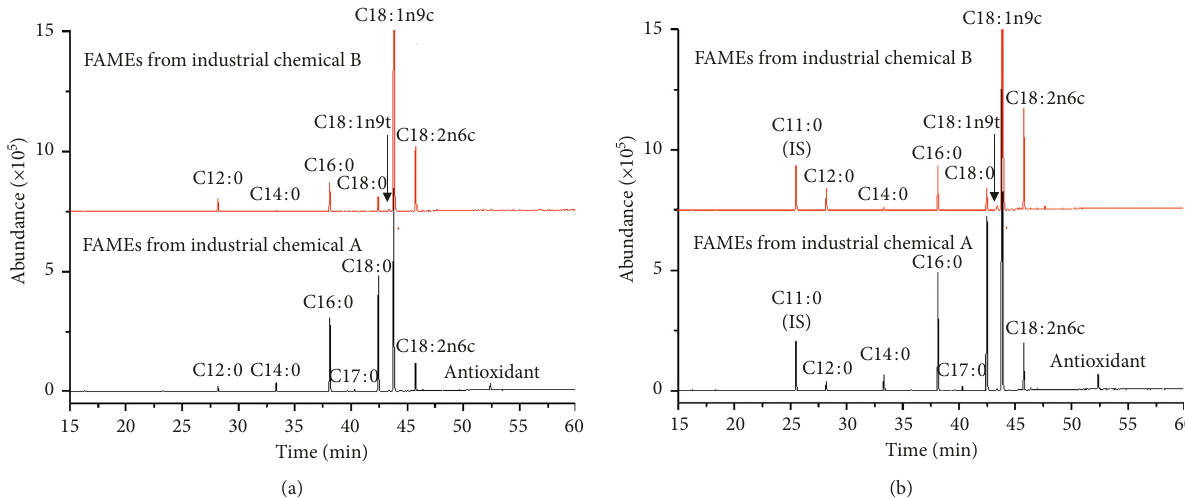
Figure 6: GC-mass chromatograms of methyl-esterified products prepared (a) directly from fatty acids zinc salts (industrial chemical A and B) by the conc. HCl/methanol/toluene and (b) by NaOH saponification/methanolic BF 3 method on hydrolysed samples. The internal standard (triundecanoin) was methyl-esterified